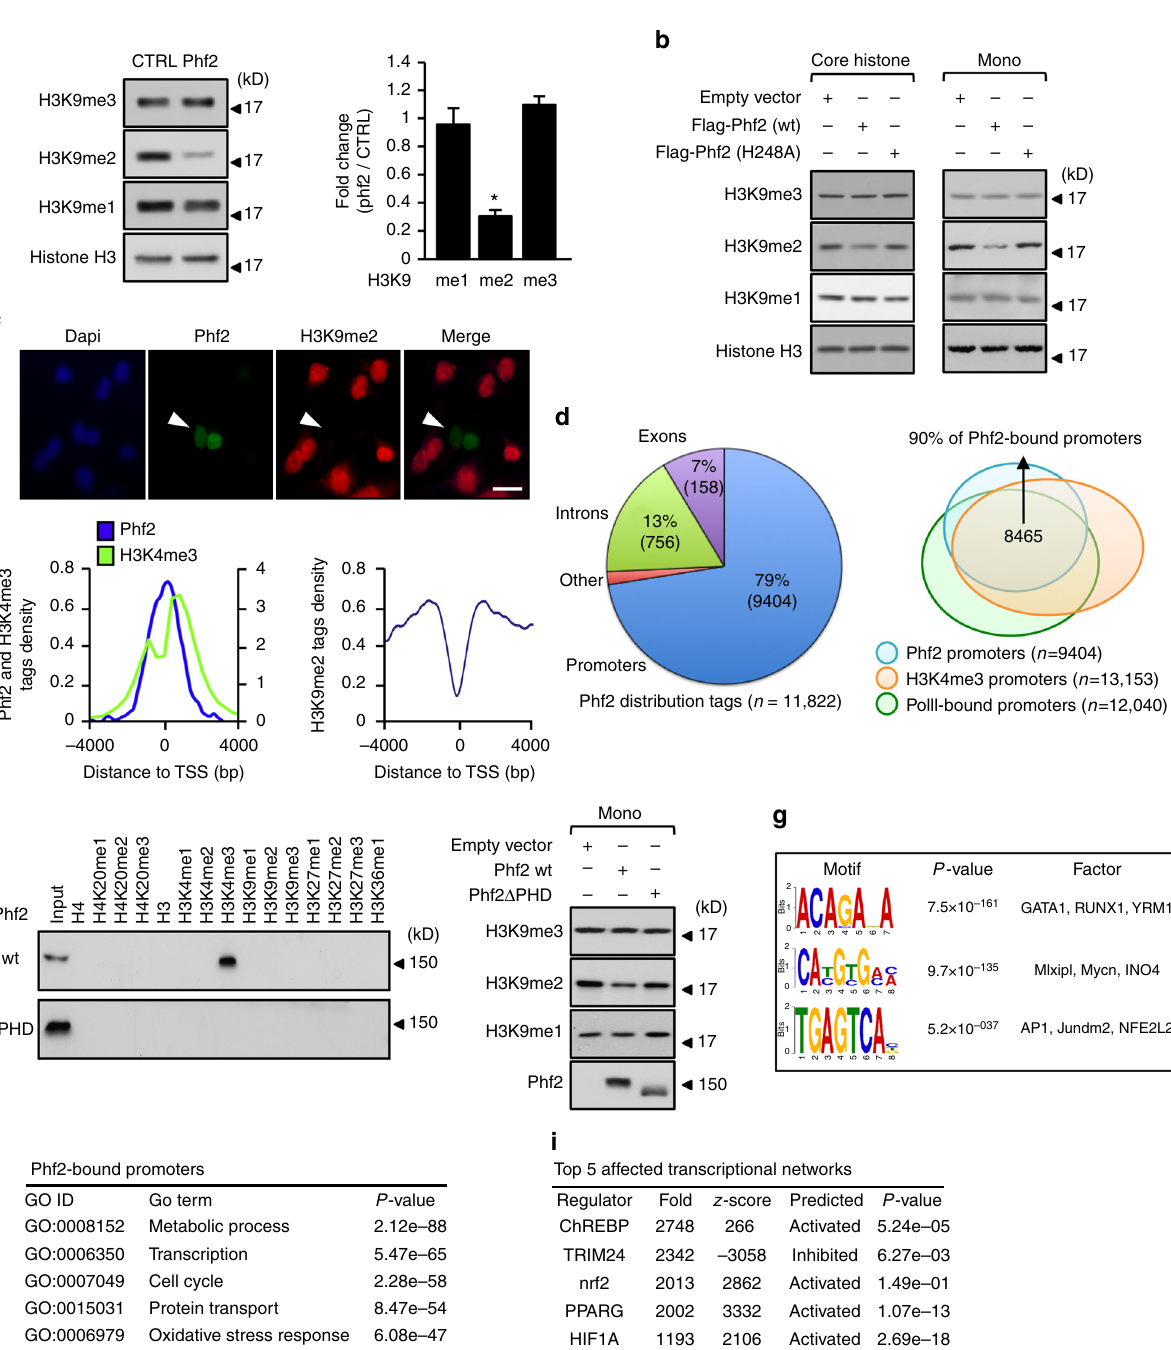
Fig. 1 Characterization of Phf2 histone demethylase activity. a, b Demethylase activity of either FLAG-tagged wild-type (wt) or H248A mutant of Phf2 immunoprecipitated (IP) from 293T cell lysates, was assessed using either recombinant methylated histones ( a ), core histones or mononucleosomes (mono) ( b ) as substrates ( n = 3). For panel a , a densitrometric analysis of H3K9 mono, di or trimethylation levels normalized to histone H3 levels was performed, values are expressed as fold over the means of the CTRL transfected cells. c Primary hepatocytes were transfected with FLAG-tagged Phf2 expression vector for 24 h. Cells were then fi xed and immunostained with the indicated antibody. Representative images shown ( n = 3). Scale bars = 40 μ m. d Genomic distribution of Phf2 and Venn diagrams showing overlap between Phf2-bound, RNA polII-bound and H3K4me3-marked promoters after ChIP-sequencing experiment from primary cultured hepatocytes incubated with 100 nM insulin and 25 mM glucose for 24 h. e Tag density plots displaying Phf2, H3K4me3, or H3K9me2 tags distribution relative to the transcriptional start site (TSS). f (Left panel) Peptide pull-down assay, mixing puri fi ed FLAG- tagged wt or Δ PHD Phf2 from 293T cells lysates with biotinylated histones tails. Pull-downs were analyzed by immunoblotting. (Right panel) Phf2 demethylase activity assessed using mononucleosomes as substrates ( n = 4). g Top enriched motifs of Phf2 ChIP-seq peaks ( n = 11,882). h Gene ontology analysis of Phf2-bound promoters from Phf2 ChIP-seq analysis. i Top enriched affected transcriptional networks in the liver of Phf2 overexpressing mice. Phf2 was overexpressed through adenoviral gene delivery in the liver of C57BL/6 J mice for 3 weeks. Microarray analysis was then performed to identify affected transcriptional networks. a Error bars represent mean ± SEM, * P < 0.01 Phf2 compared to CTRL (unpaired t